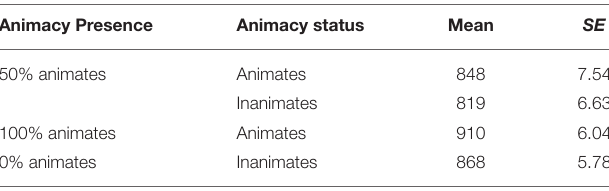
TABLE 8 | Mean reaction times and standard errors for animate and inanimate nouns in Experiment